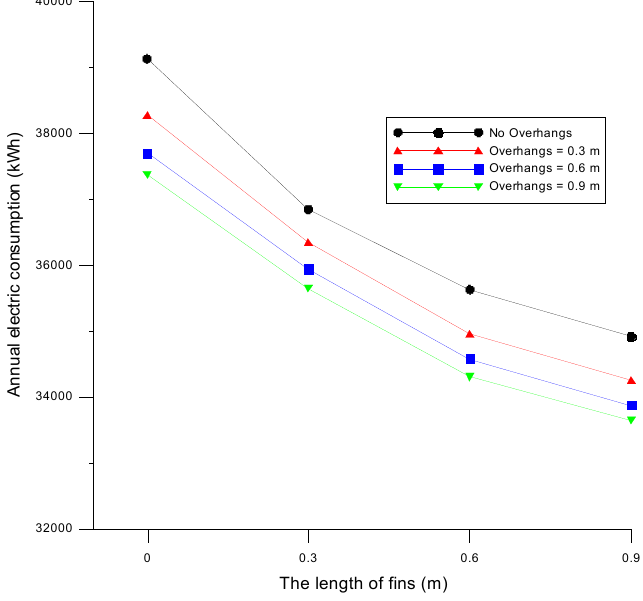
Figure 8. Comparison of the annual energy consumption densities between the baseline and various shading